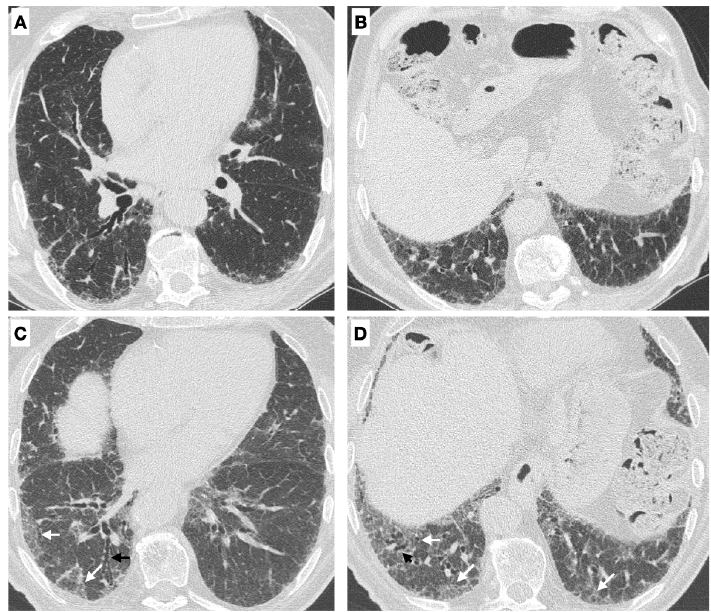
Figure 2. ( A , B ) Axial high resolution CT images show a subpleural irregular interlobular septal thickening and subtle ground glass opacities in the lower lobes. ( C , D ) A chest CT scan performed 1 year later demonstrated the radiological disease progression due to the increase in extent and severity of irregular inter and intralobular septal thickening (white arrows) and traction bronchiecta- sis/bronchiolectasis (black arrows).